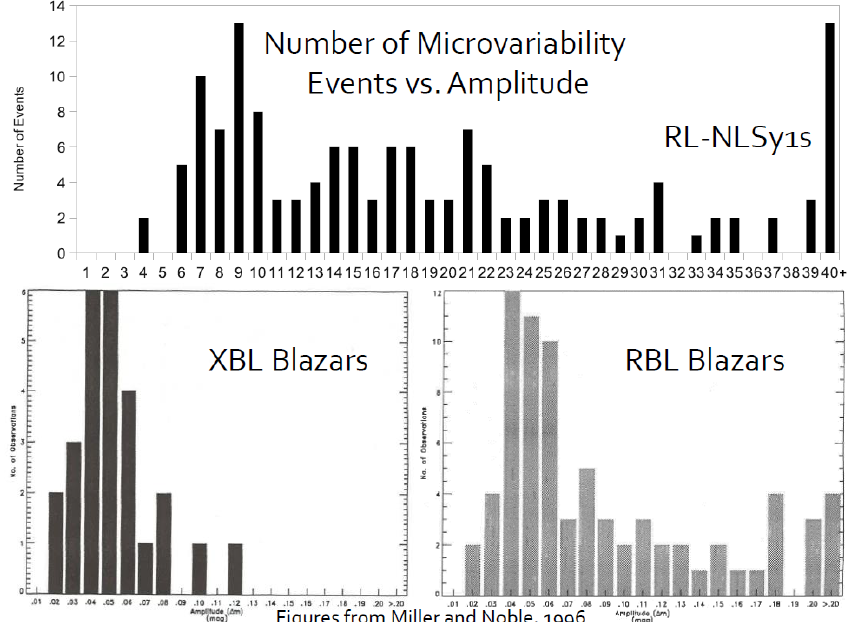
Figure 7. Histograms showing the number of microvariability events vs. amplitude. The top figure is reproduced from Maune [18] and uses a scale of 0.01 magnitude on the x -axis. The bottom two figures were originally printed in Miller and Noble [17] and use a one-magnitude scale. Note that the XBL sample was generally brighter than the other two, allowing for a bias in the detection of excess low-amplitude events.